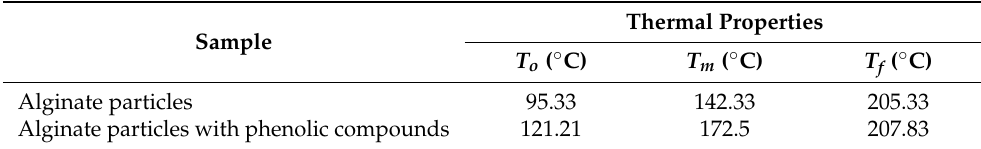
Table 3. Thermal properties of alginate particles with and without phenolic extract of Spirulina sp. LEB-18. Thermal Properties Sample Alginate particles 95.33 142.33 205.33 Alginate particles with phenolic compounds 121.21